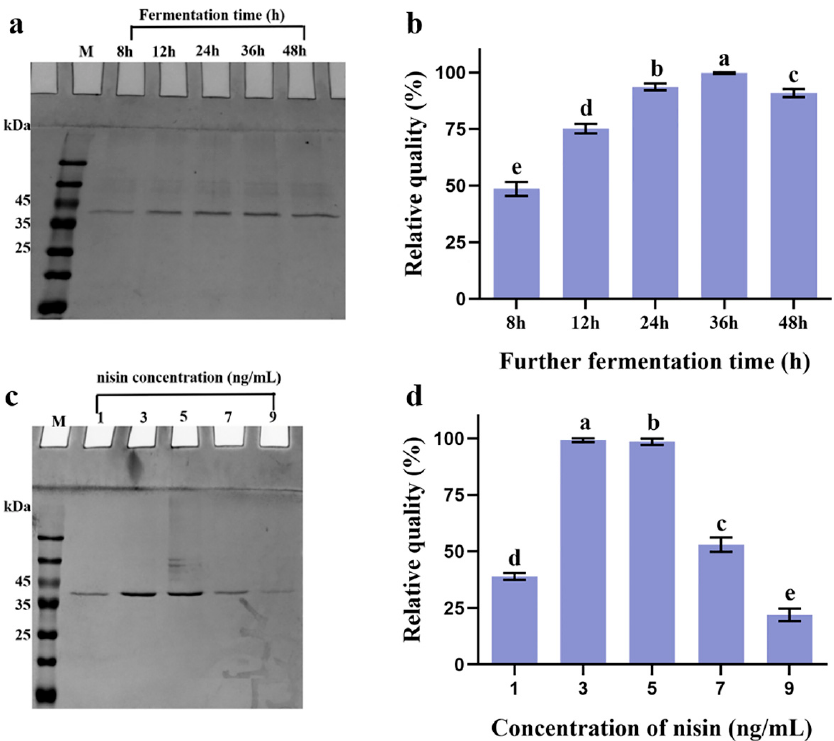
Figure 1. Expression of pro-BaMTGase and optimization of fermentation conditions. M: molecular weight marker. ( a ) Optimization of fermentation time. 1 ng/mL nisin was added when the strain reached the logarithmic phase, and the culture continued for another 8 h, 12 h, 24 h, 36 h, and 48 h. ( b ) Relative quantities of SPUsp45-pro-BaMTGase produced by L. lactis NZ9000 (pNZ8048-SP usp45-pro-Bamtg ) induced with 1 ng/mL nisin. ( c ) Optimization of inducer concentration. The expression of pro-BaMTGase after induction for 36 h with 1, 3, 5, 7, 9 ng/mL nisin. ( d ) Relative expression quantities of SPUsp45-pro-BaMTGase in L. lactis NZ9000 (pNZ8048-SP usp45-pro-Bamtg ) induced with nisin for 36 h at different concentrations. a–e above the bars in ( b , d ) represent the significant differences ( p < 0.05).